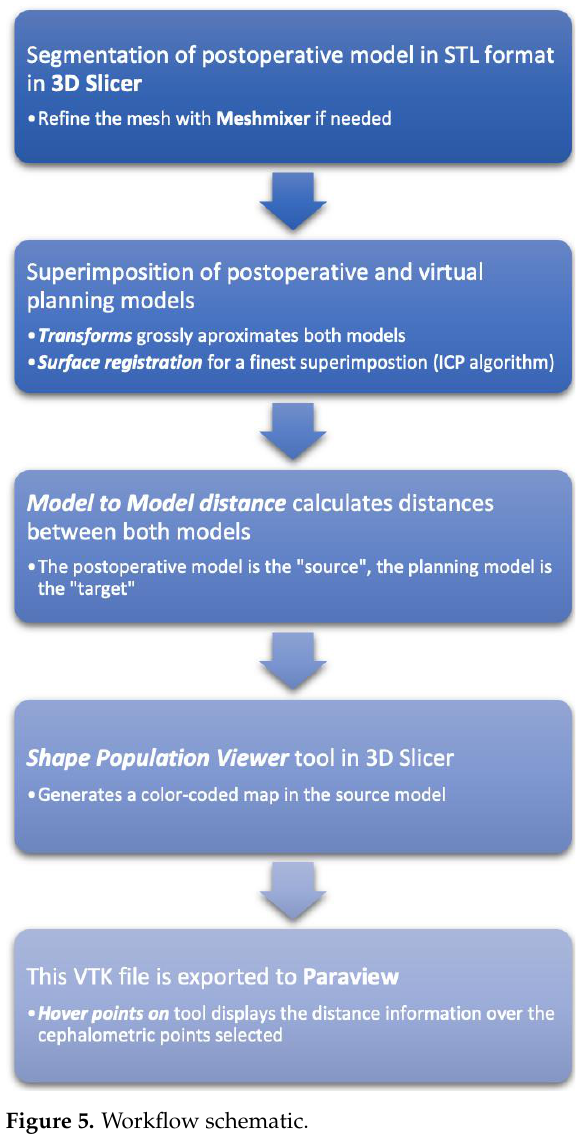
Figure 5. Workflow schematic.